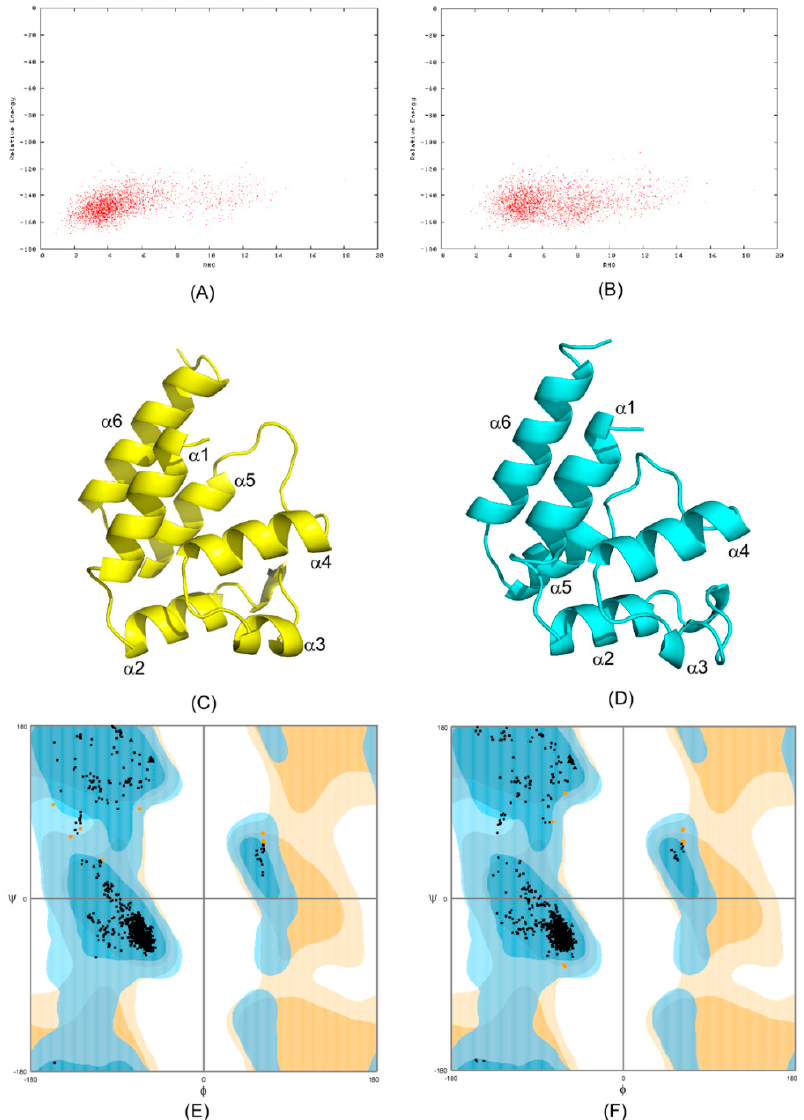
Figure 1. Chemical shift (CS)-Rosetta de novo structural generation for phosphoprotein enriched in astrocytes-15 kDa (PEA-15) in free and extracellular signal-regulated kinase 2 (ERK2)-bound form. ( A ) Plot of Rosetta energy versus C α root-mean-square deviation (RMSD) for the free form. ( B ) Plot of Rosetta energy versus C α RMSD for the ERK2-bound form. ( C ) Lowest energy structure of PEA-15 in free form. ( D ) Lowest energy structure of PEA-15 in ERK2-bound form. ( E ) Ramachandran plot for free-form PEA-15. ( F ) Ramachandran plot for the ERK2-bound PEA-15. Both Ramachandran plots show 98.9% of residues in a favored region (black dots), 1.1% in an allowed region (orange dots), and no residues in a disallowed region.